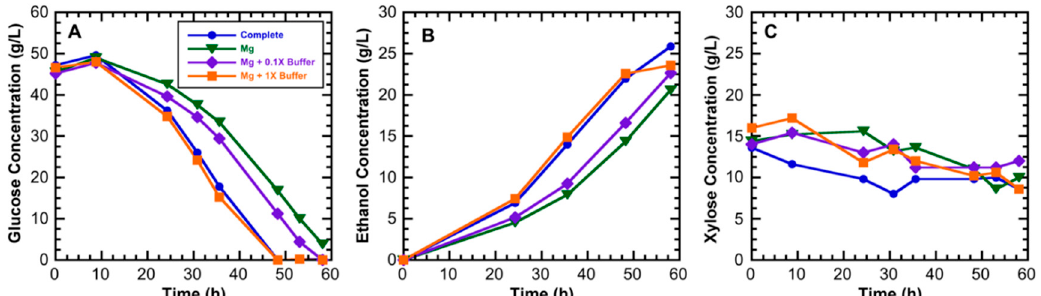
Figure 2. E ff ect of the phosphate bu ff er on the glucose consumption rates and ethanol productivities for S. pastorianus on sugarcane bagasse hydrolysate. ( A ) Glucose; ( B ) ethanol; ( C ) xylose. Cultures in standard medium (Complete, (cid:8) ); magnesium sulfate solution (Mg, (cid:72) ); magnesium sulfate solution and one-tenth the bu ff er concentration (Mg + 0.1 × Bu ff er, (cid:7) ); and magnesium sulfate solution and the normal bu ff er concentration (Mg + 1 × Bu ff er, (cid:4) ). The legend for all panels is shown in ( A ). Only single cultures were conducted for each condition as this was a screening study.